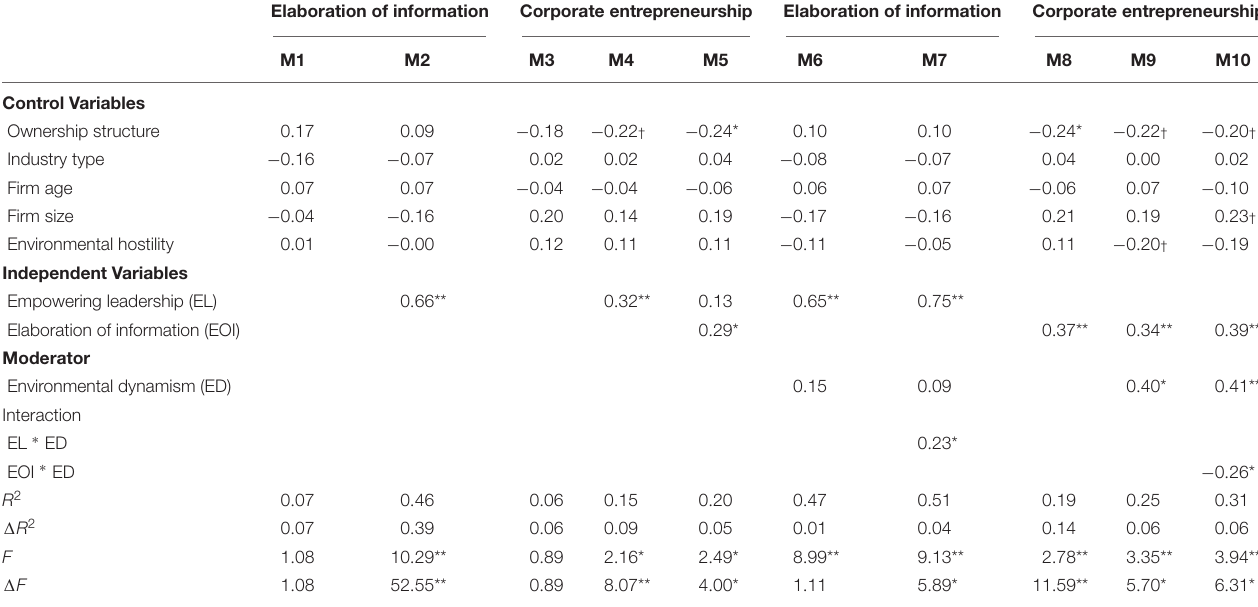
TABLE 3 | Result of regression analysis a